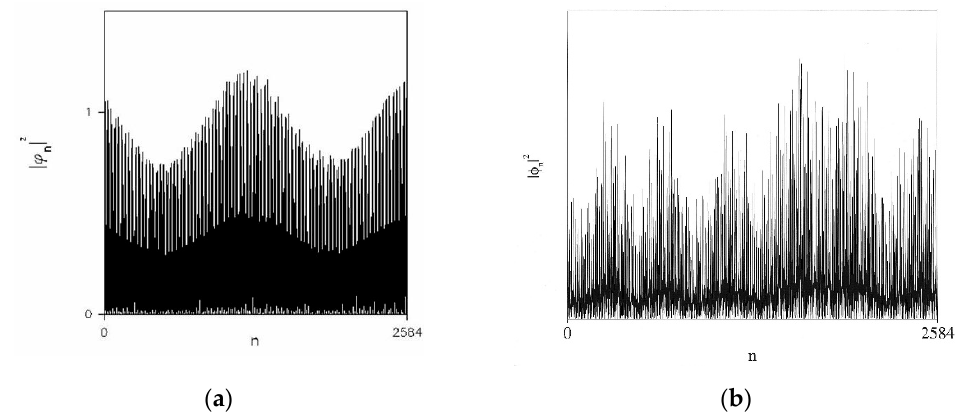
Figure 3. Two examples of different kinds of critical wave functions in one-dimensional Fibonacci QCs: ( a ) Electronic charge distribution for an extended state with E = − 13/50 = − 0.26 and a transmission coefficient T = 1 (reprinted from Maciá-Barber E. Aperiodic Structures in Condensed Matter: Fundamentals and Applications; CRC Press: Boca Raton, FL, 2009. With permission from CRC Taylor & Francis group); ( b ) electronic charge distribution for a low diffusivity state with E = –0.335440… and a transmission coefficient T = 0.4689….